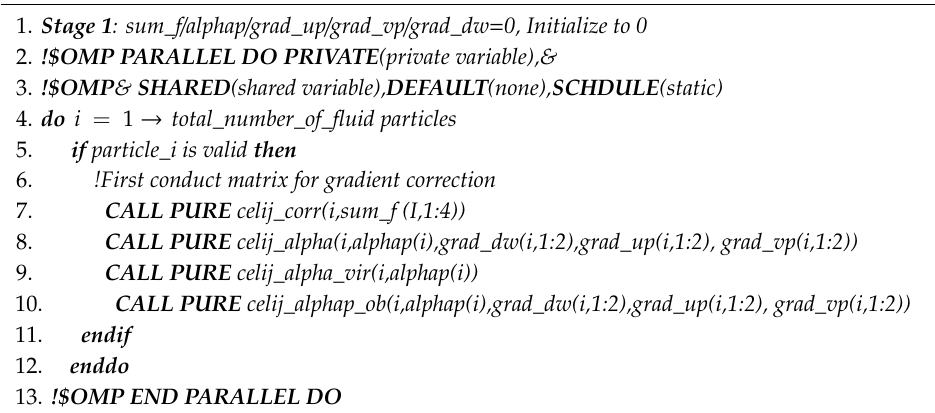
Algorithm 5: Calculation of fluid particle velocity and water depth gradient.